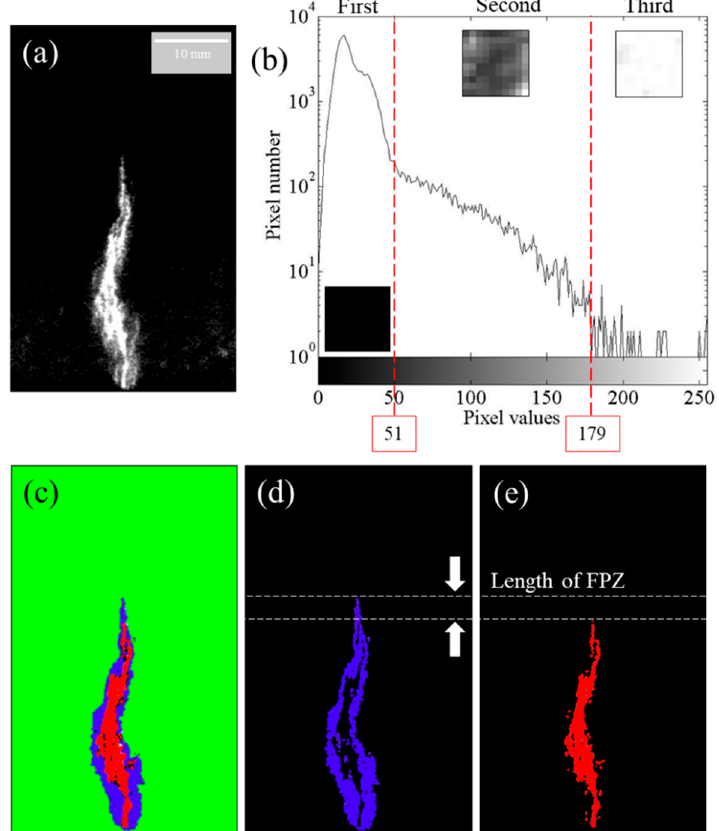
Figure 6. The histogram of ( a ) has been derived using MATLAB software, which is illustrated in ( b ). Based on the histogram, ( a ) has been segmented into three different zones as illustrated in ( c ) by green, blue, and red colors. The Second Zone and the Third Zone are illustrated separately in ( d,e ), respectively; meanwhile, the length of the FPZ is illustrated from ( d,e ).